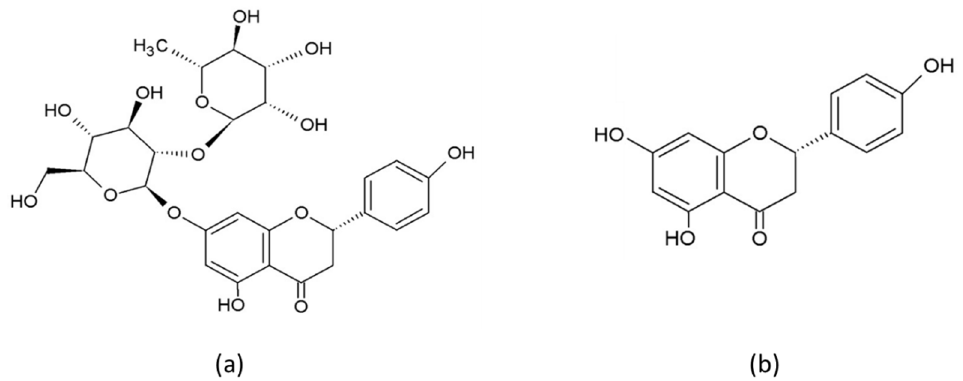
Figure 1. Chemical structure of naringin ( a ) and naringenin ( b ).